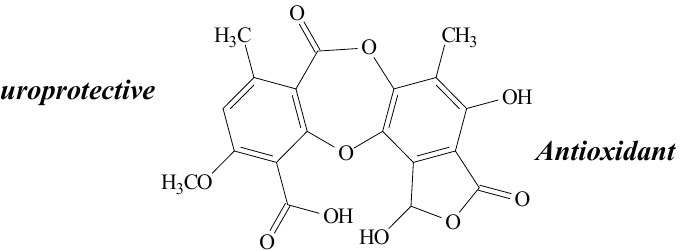
Figure 7. Stictic acid structure and biological activities.